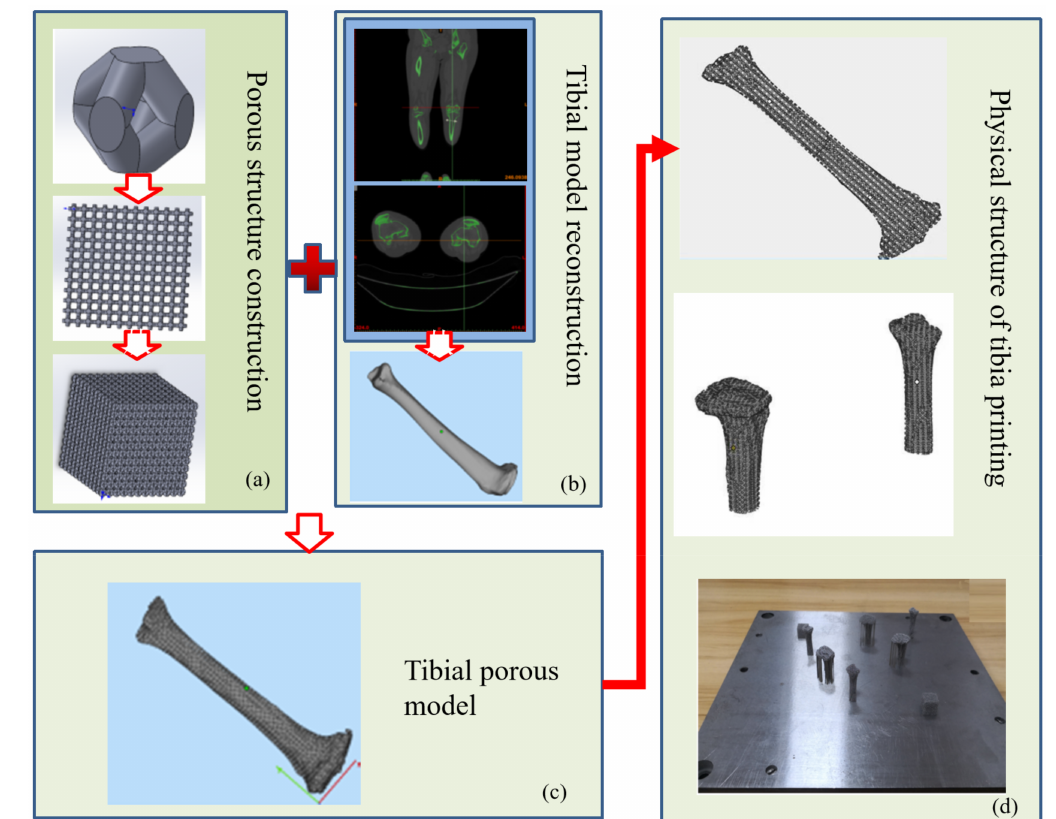
Figure 14. Personal tibial porous model construction process.